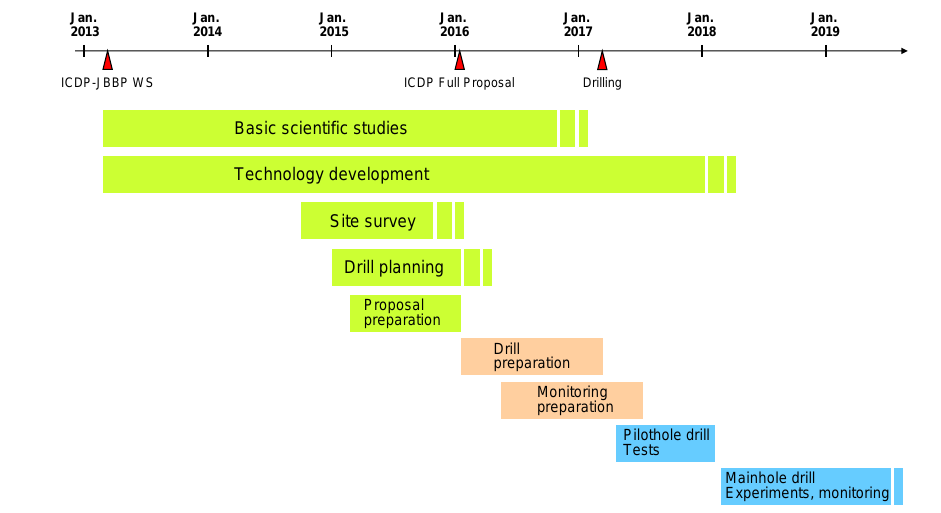
Figure 3. Roadmap for the development of the full JBBP proposal and subsequent drilling A number of current geothermal projects target supercritical fluids in shallow, still-hot, molten igneous intrusions in young volcanic rocks along plate boundaries and at hot spots. These include established geothermal fields in Iceland, New Zealand, the Philippines, Indonesia, Italy, and the United States. International collaboration, particularly with ICDP high-temperature geothermal projects worldwide, is of critical importance for success of the JBBP by sharing of scientific knowledge and technology.